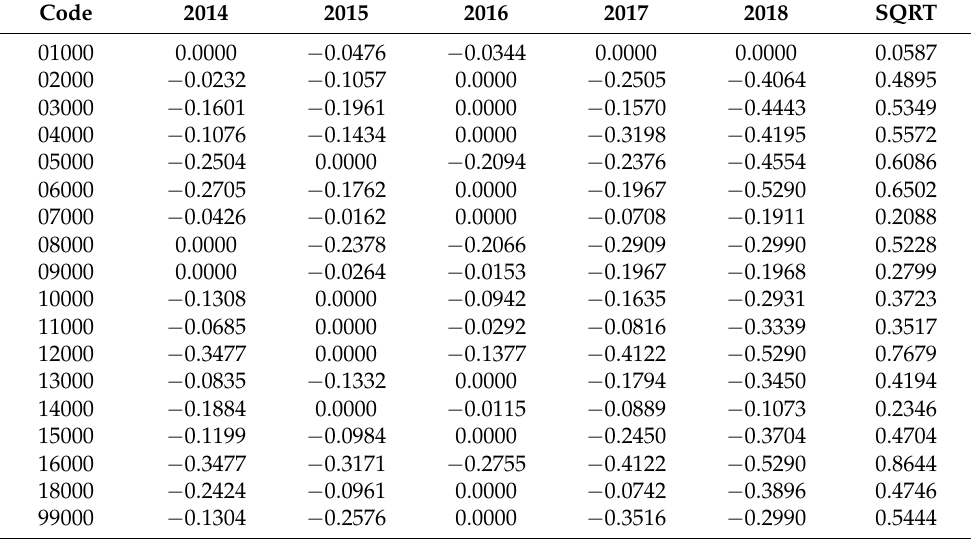
Table A10. The third step of TOPSIS analysis (positive ideal distance) is adopted for the deficiency data of Taiwanese